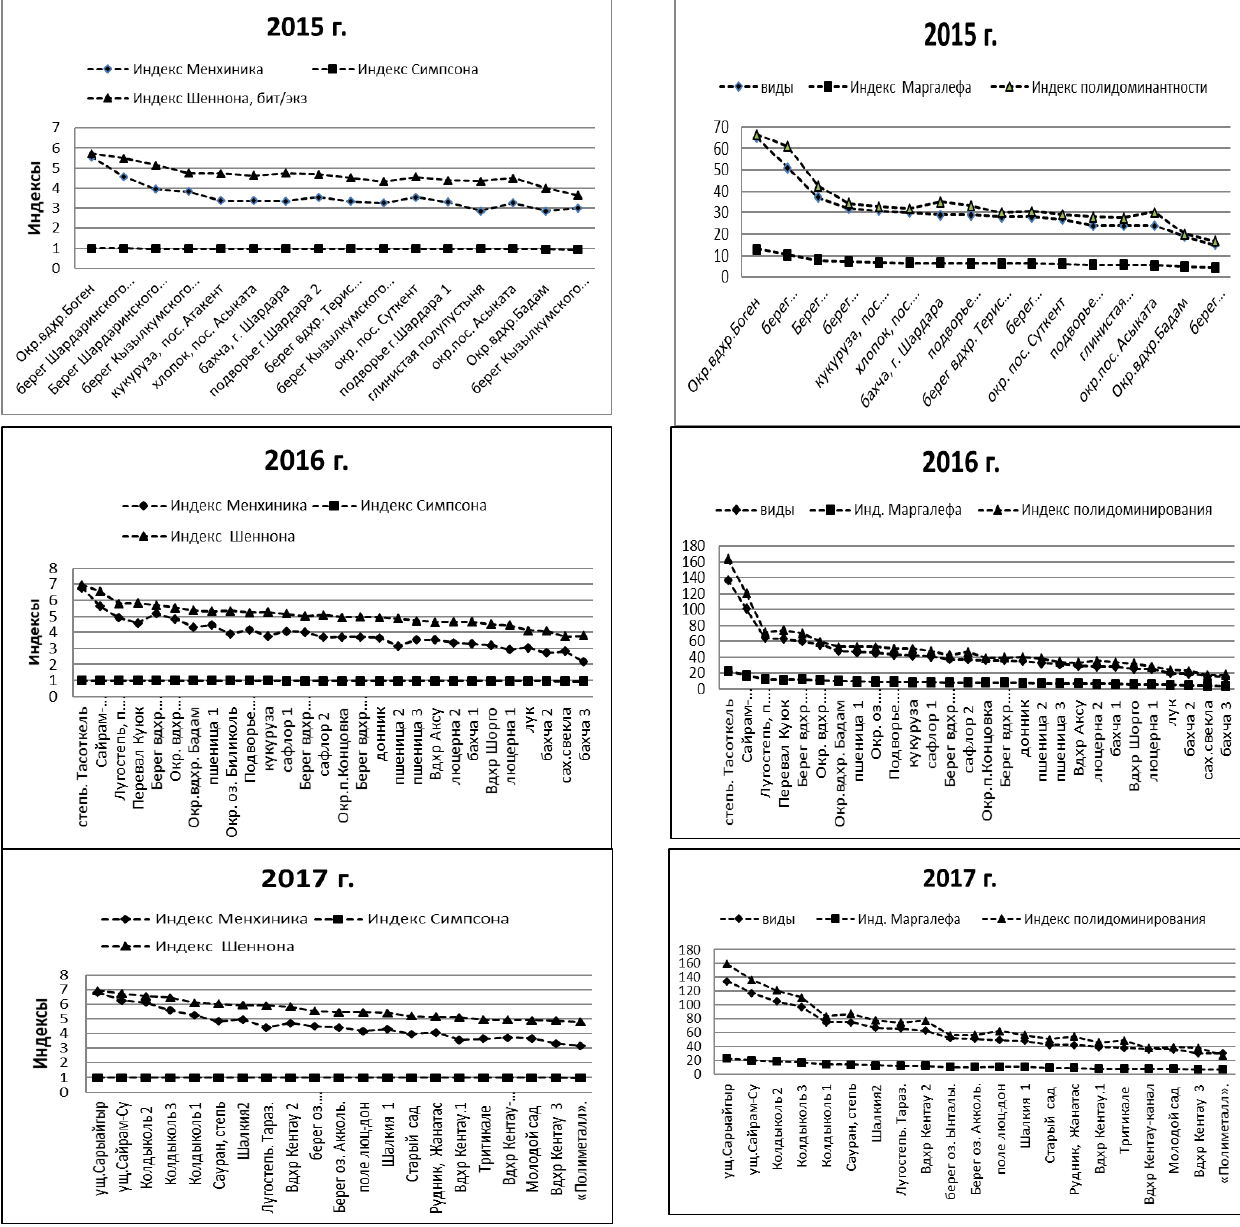
Для оценки информативности различных индексов, применительно к результатам визуальных учетов, были вычислены часто используемые индексы: Шеннона-Уивера, Менхиника, Маргалефа и два производных от индекса Симпсона. Результаты, отражающие особенности изменения индексов в ряду исследованных биотопов изображены на рисунке 3.